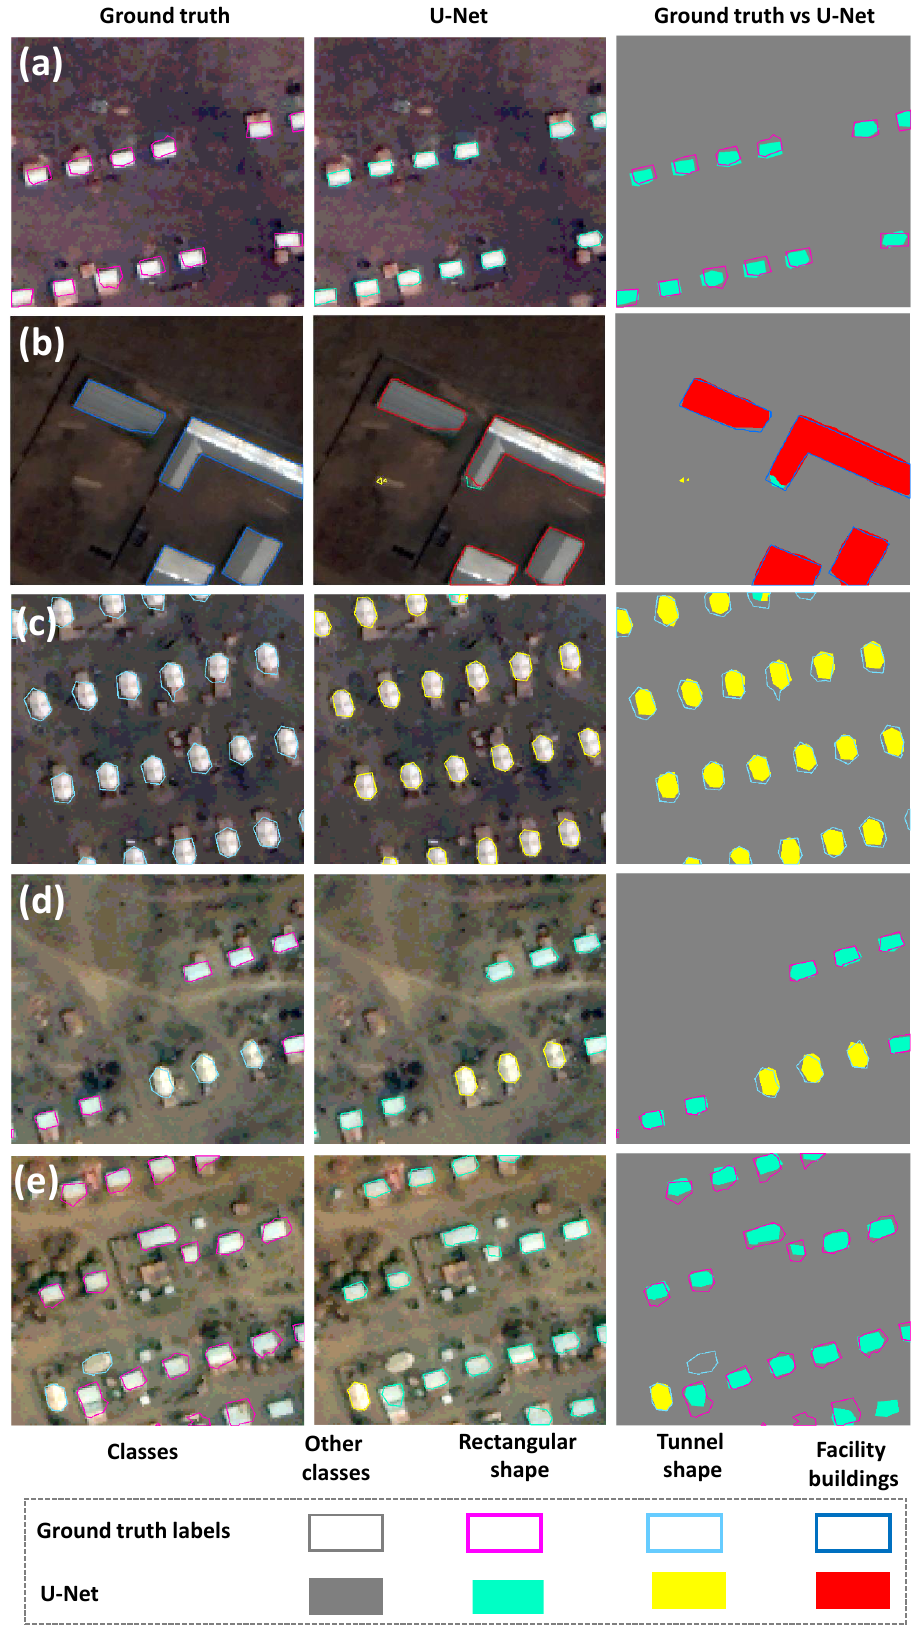
Figure 5. Example classification results on the test set of image patches resulting from U-net and comparison with the ground truth labels. The image patches ( a – e ) are selected from the test